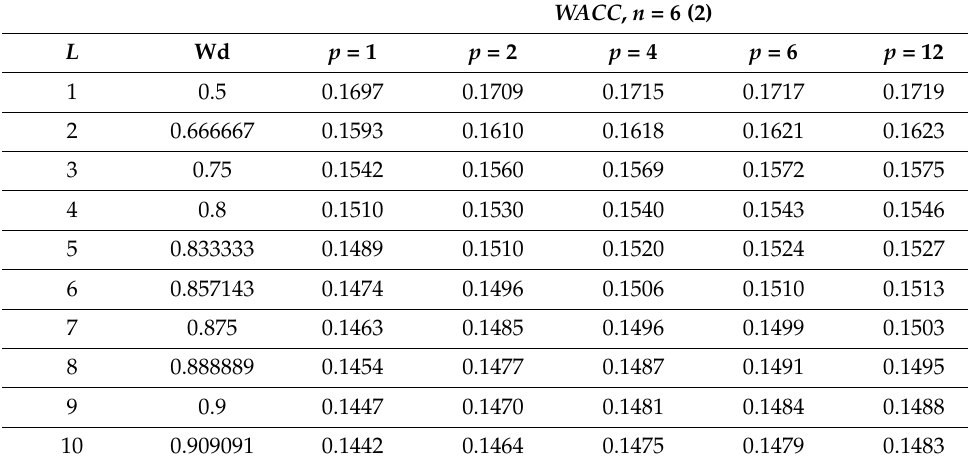
Table 4. The dependence of the WACC on the leverage level ( L ) of a six-year-old company for advance profit tax payments with frequencies of p = 1, 2, 4, 6 and 12.